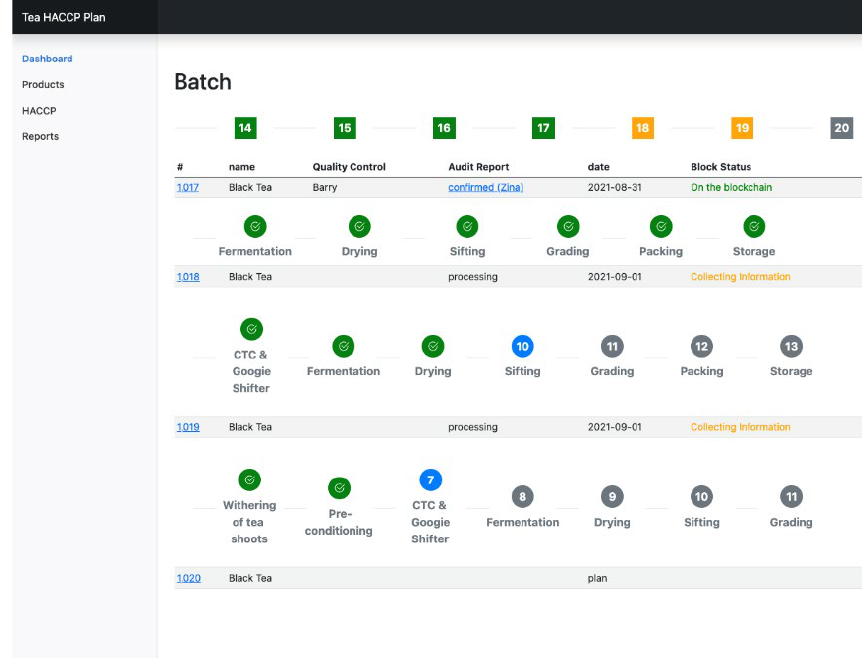
Figure 14. The system implementation of batch tracking.